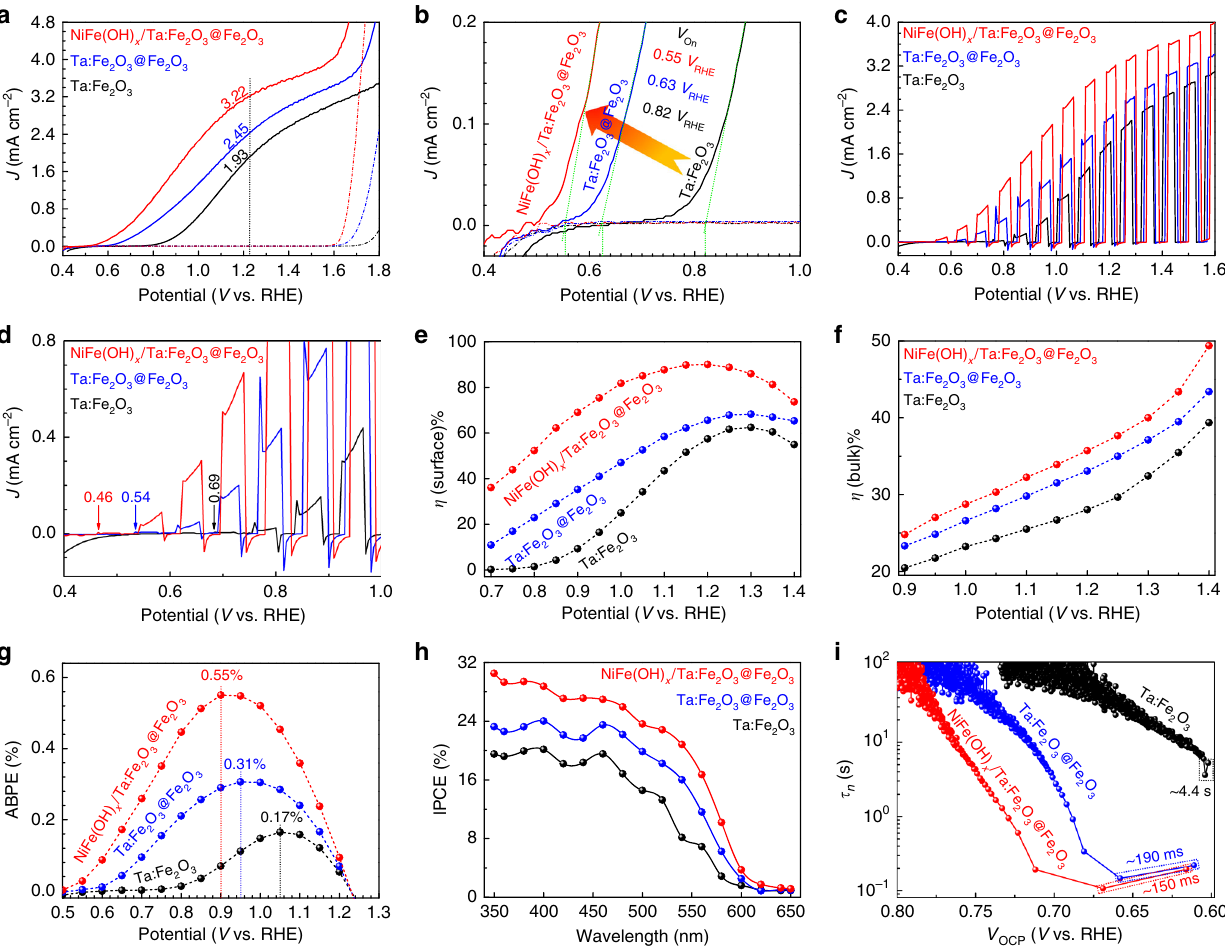
Fig. 4 Photoelectrochemical performance. a J – V curves, b extracted V on , c chopped J – V curves, d local enlarged chopped J – V curves, e surface charge separation, f bulk charge separation, g ABPE, h IPCE, and i OCP-derived carrier lifetimes for Ta:Fe 2 O 3 , Ta:Fe 2 O 3 @Fe 2 O 3 , and NiFe(OH) x /Ta:Fe 2 O 3 @Fe 2 O 3